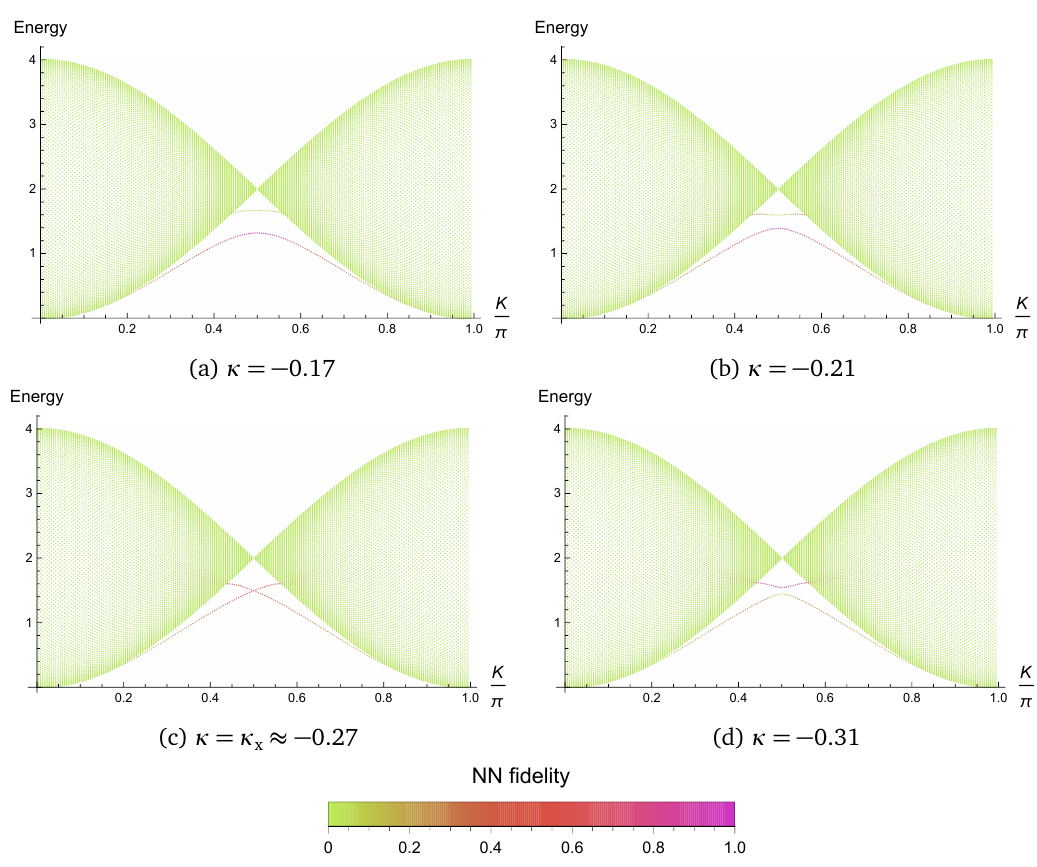
Figure 2: Two-magnon excitations and nearest neighbor fidelity for the antiferro- magnetic quantum Ising-Kawasaki spin chain with N = 200 around κ